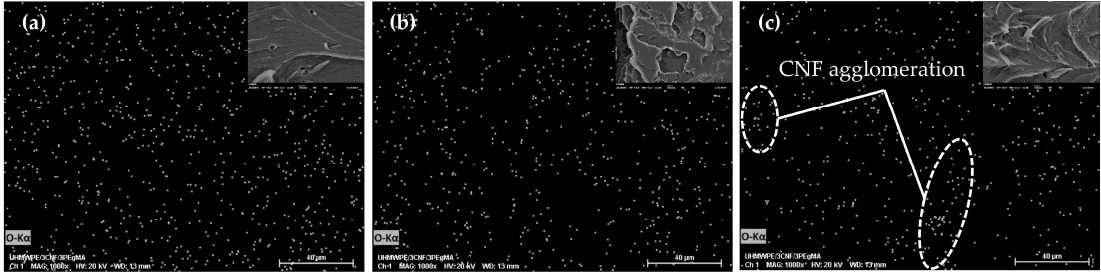
Figure 3. SEM-EDS images of UHMWPE/CNF bionanocomposites fabricated at temperatures ( a ) 150 °C, ( b ) 170 °C, and ( c ) 190 °C at constant rotational speed (45 rpm) and mixing time (30 min). The presence of agglomeration restricted interfacial properties between the polymer matrix and filler, thus inhibiting the e ffi cient stress transfer when the load was applied. The resulted ine ffi cient stress transfer caused uneven stress distribution, eventually leading to crack or debonding